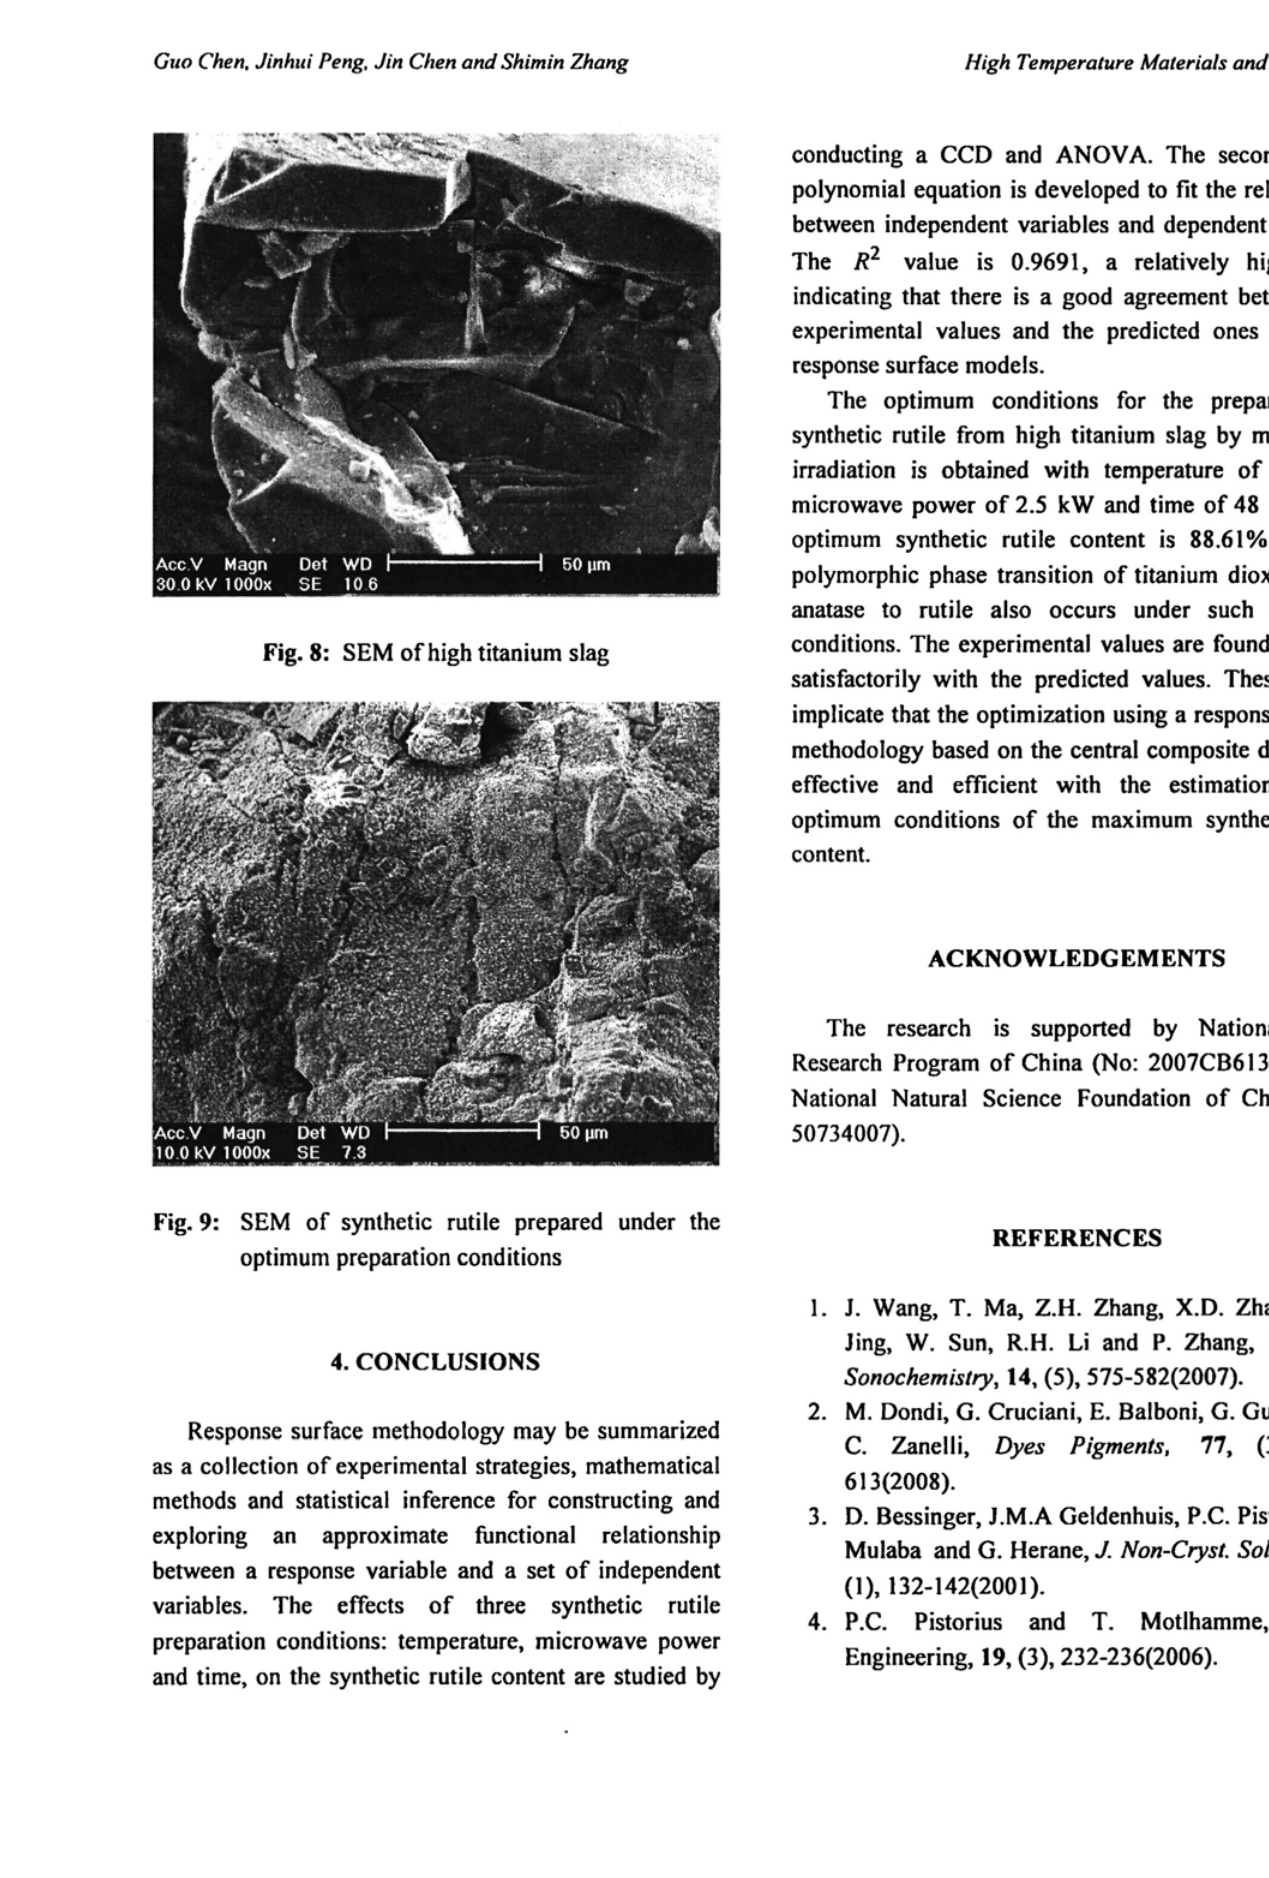
Fig. 8: SEM of high titanium slag